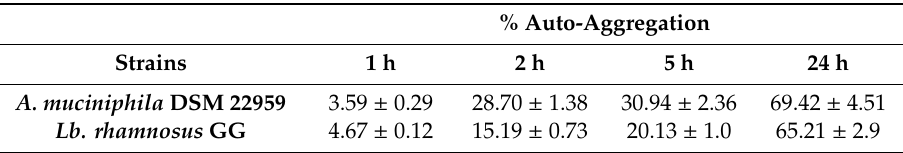
Table 3. Auto-aggregation percentages of A. muciniphila DSM 22959 and Lb. rhamnosus GG strains evaluated after 1, 2, 5, and 24 h of